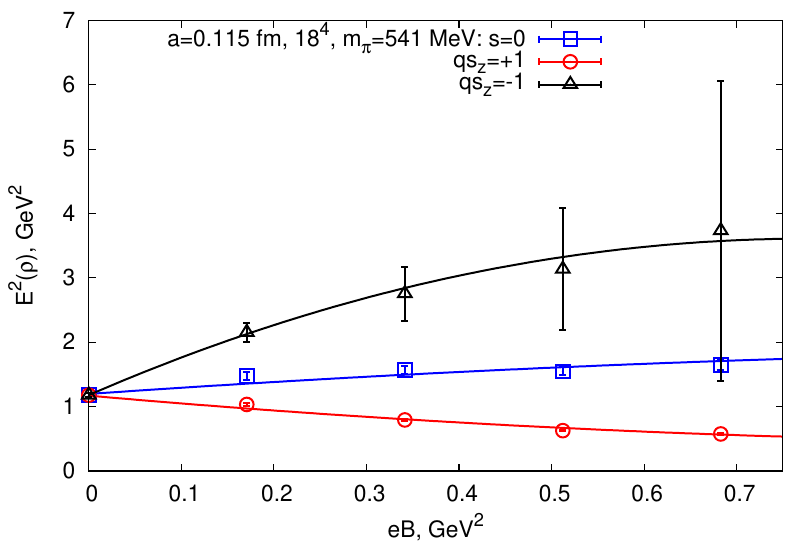
Figure 4 . The energy squared of the charged (cid:26) meson for the lattice volume 18 4 , lattice spacing 0 : 115 fm and the pion mass m (cid:25) = 541 MeV in dependence on the meson charge and spin projection on the magnetic (cid:12)eld